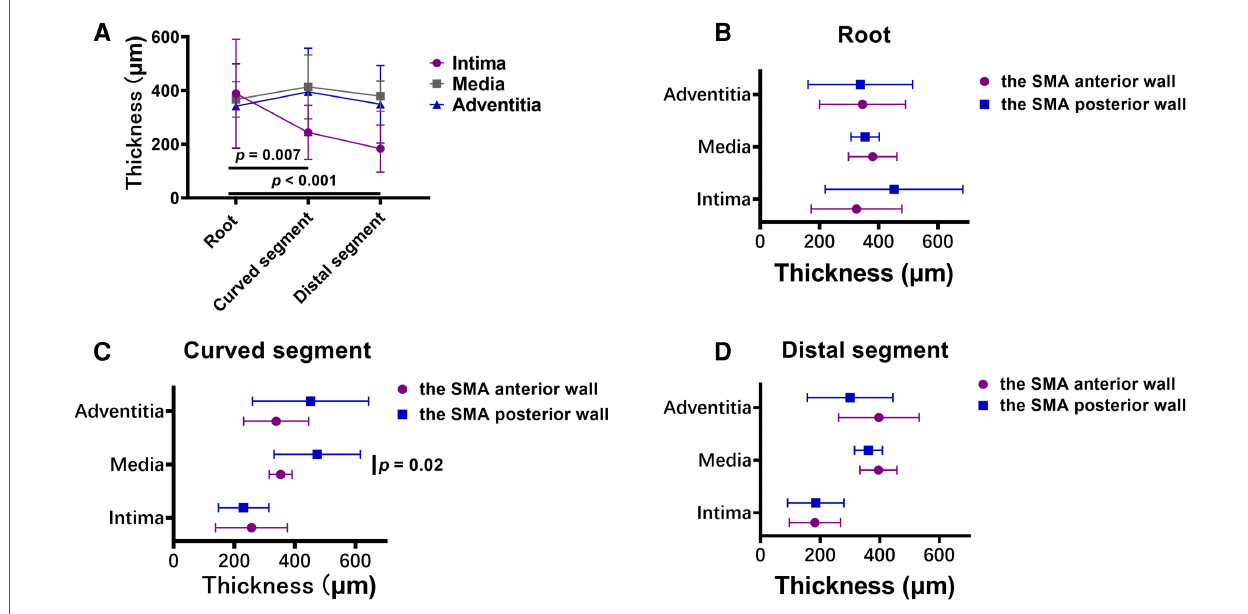
FIGURE 6 ( A ) broken-line graphs of the mean value of the thickness of each layer of the vascular wall in the three superior mesenteric artery (SMA) segments. ( B – D ) The thickness of each layer of the vascular wall in the root ( B ), curved segment ( C ), and distal segment ( D ) of the